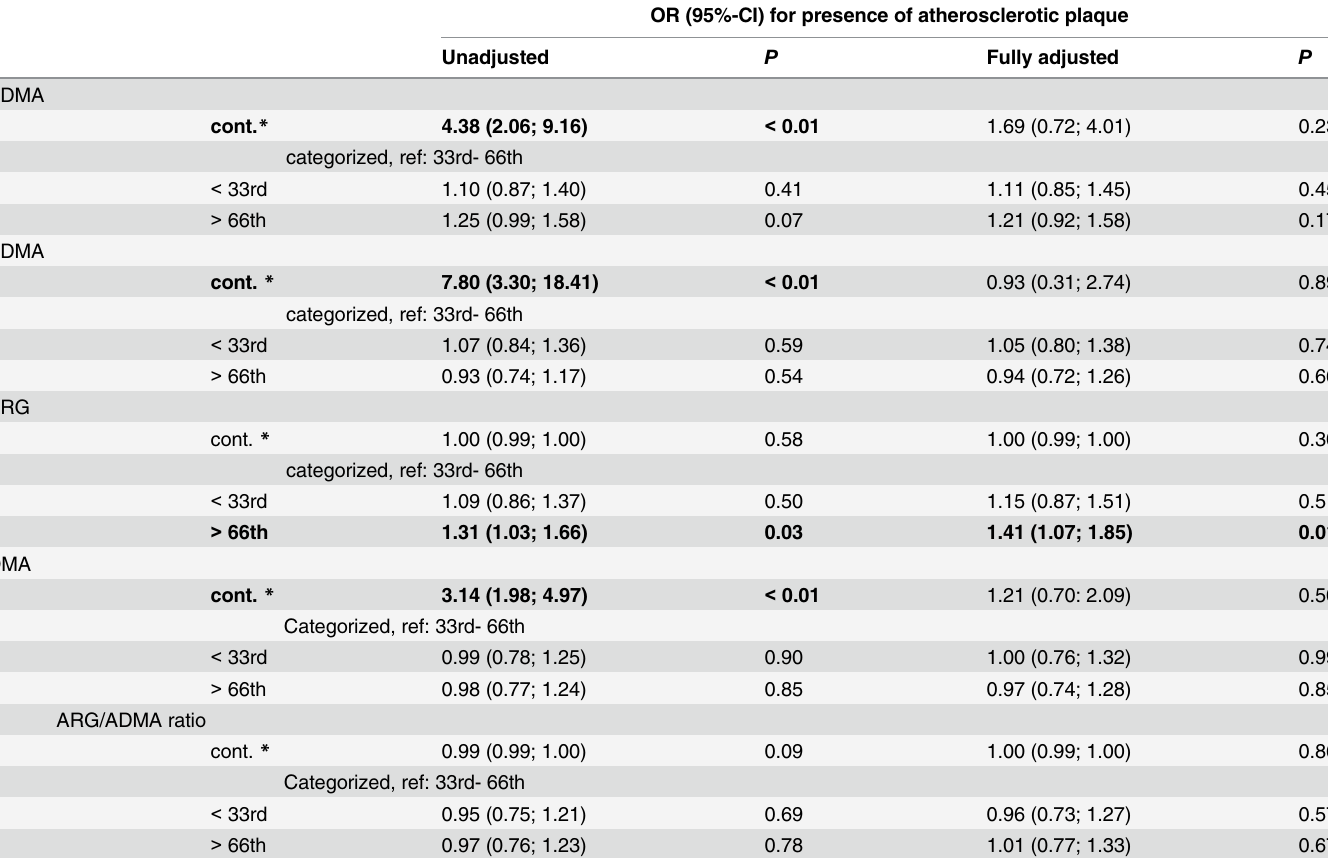
Table 3. Association of arginine derivatives with the presence of atherosclerotic plaques.